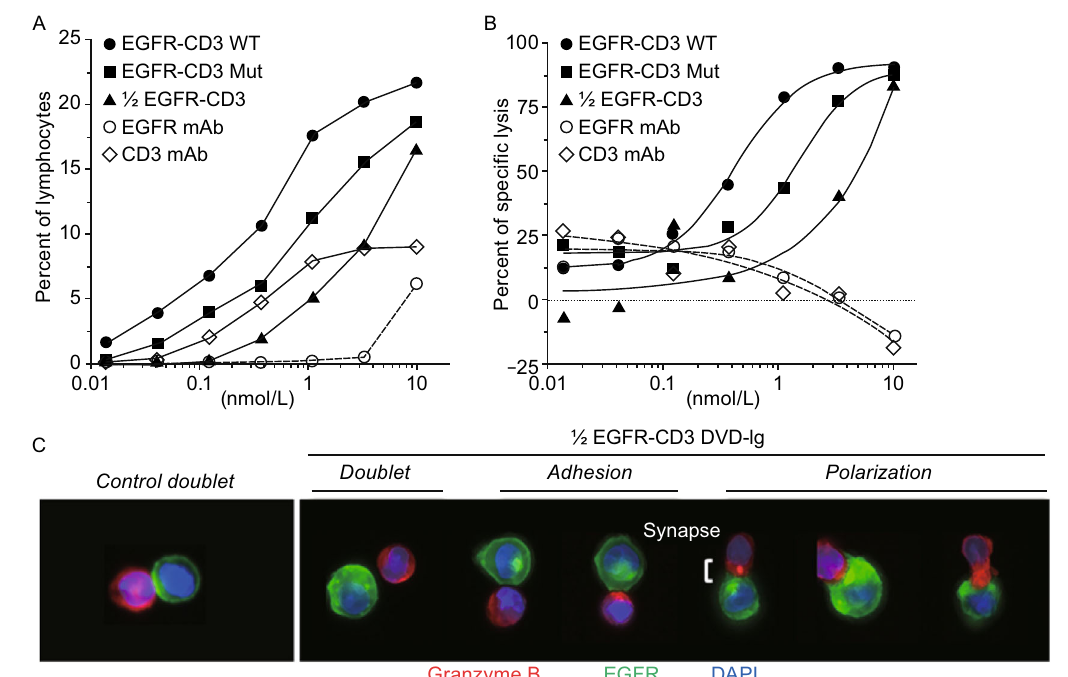
Figure 3. DVD Halfbodies promote conditional T cell activation and redirected T cell killing of tumor cells in vitro . (A) FACS analysis of CD8+CD25+ of huPBMC taken from rCTL assay. (B) Potency of anti-EGFR/anti-CD3 DVD-Ig molecules with huIgG1-wild type (EGFR-CD3 WT, circles), huIgG1-mutant (EGFR-CD3 Mut, squares), and anti-EGFR/anti-CD3 Half DVD-Ig molecule (1/2 EGFR-CD3, triangles) in a redirected cytotoxicity (rCTL) assay. Control anti-EGFR mAb (EGFR mAb, open circles) and anti-CD3 (CD3 mAb, open diamonds) mAbs were included in assays. Data are representative of 3 separate experiments from 1 huPBMC donor. (C) Anti-EGFR/Anti-CD3 Half DVD-Ig molecule promote immune synapse formation between T cells (granzyme B+, red) and A431 tumor cells (green), and induced T cell polarization of granzyme B (red) as visualized by